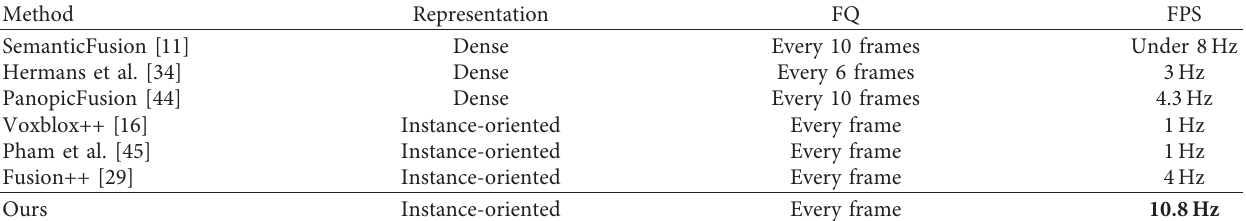
Figure 2: Map integration of the proposed system, showing the interaction between multiple layers and with incoming sensor data through integrators. Table 1: Comparison of run-time performance. FQ denotes the frequency recognition of when the input frame is performed, and the class probabilities of the 3D map are updated.